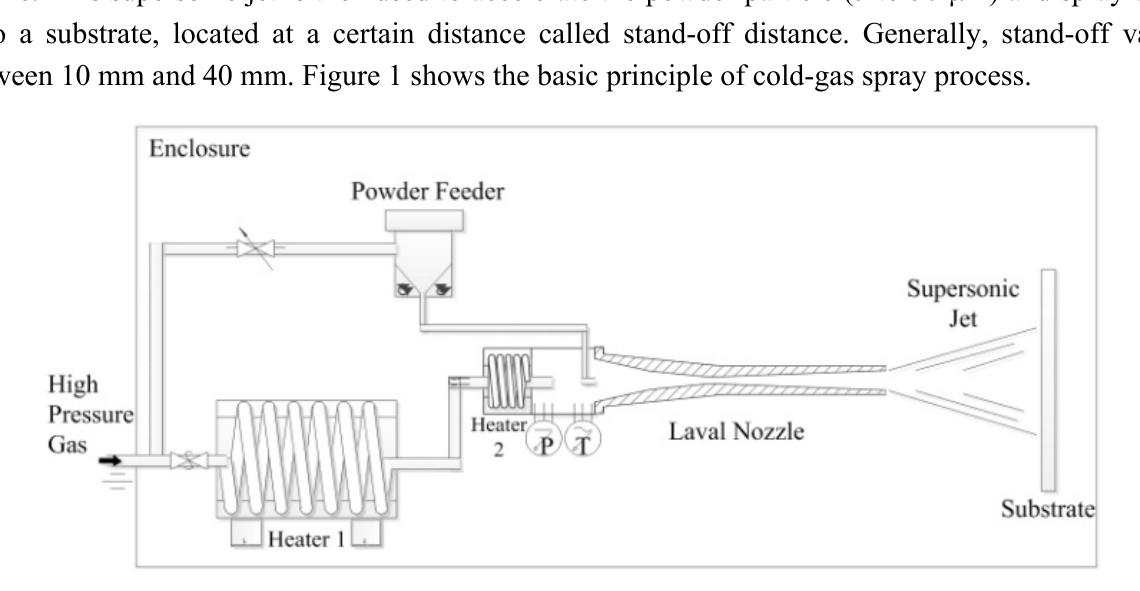
Figure 1. Schematic diagram of cold spray system